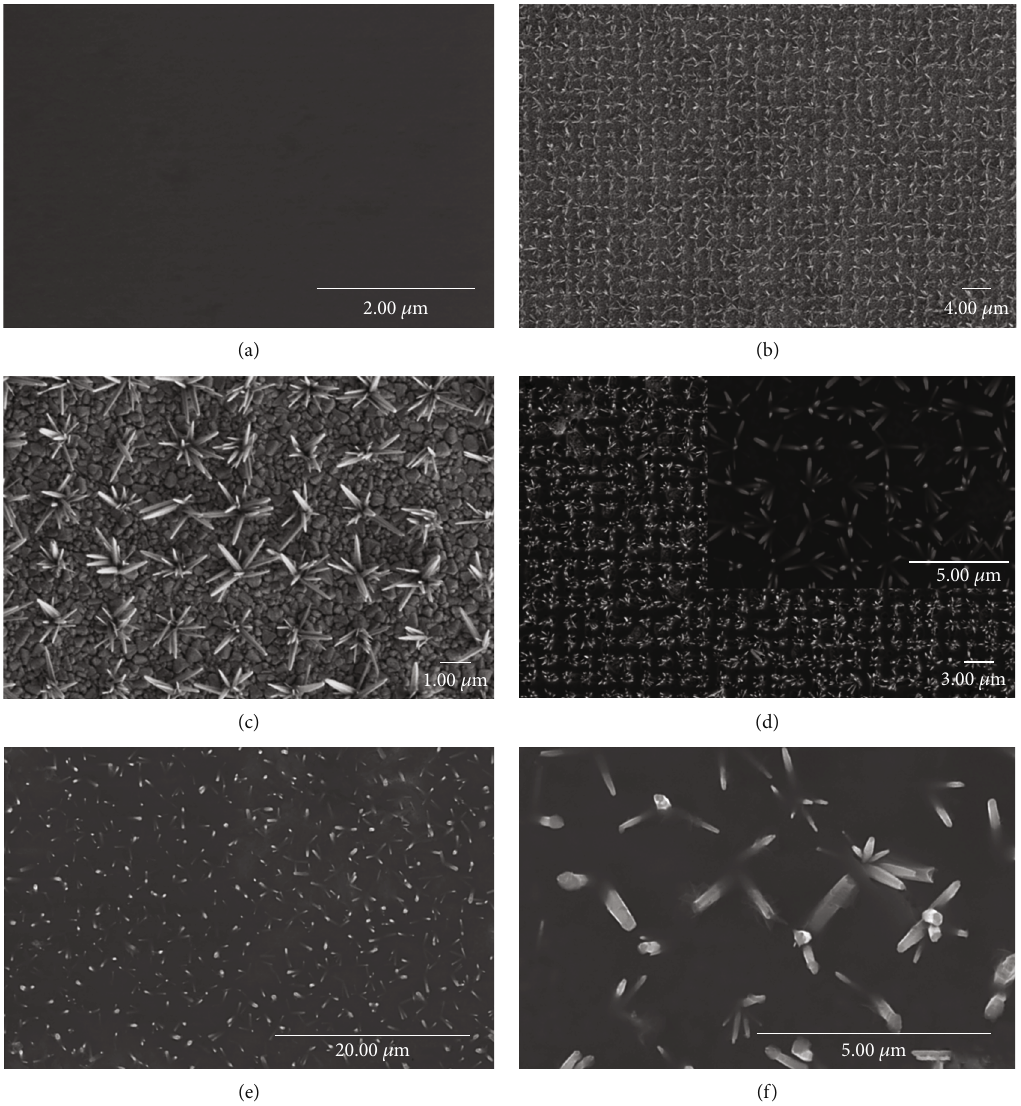
Figure 3: FESEM images of (a) diazocine fi lm on FTO; (b) and (c) ZnO NR array; (d) diazocine fi lm/ZnO NR hybrid; (e) diazocine fi lm/ ZnO NR/Pt NP hybrid; and (f) magni fi ed diazocine fi lm/ZnO NR/Pt NP